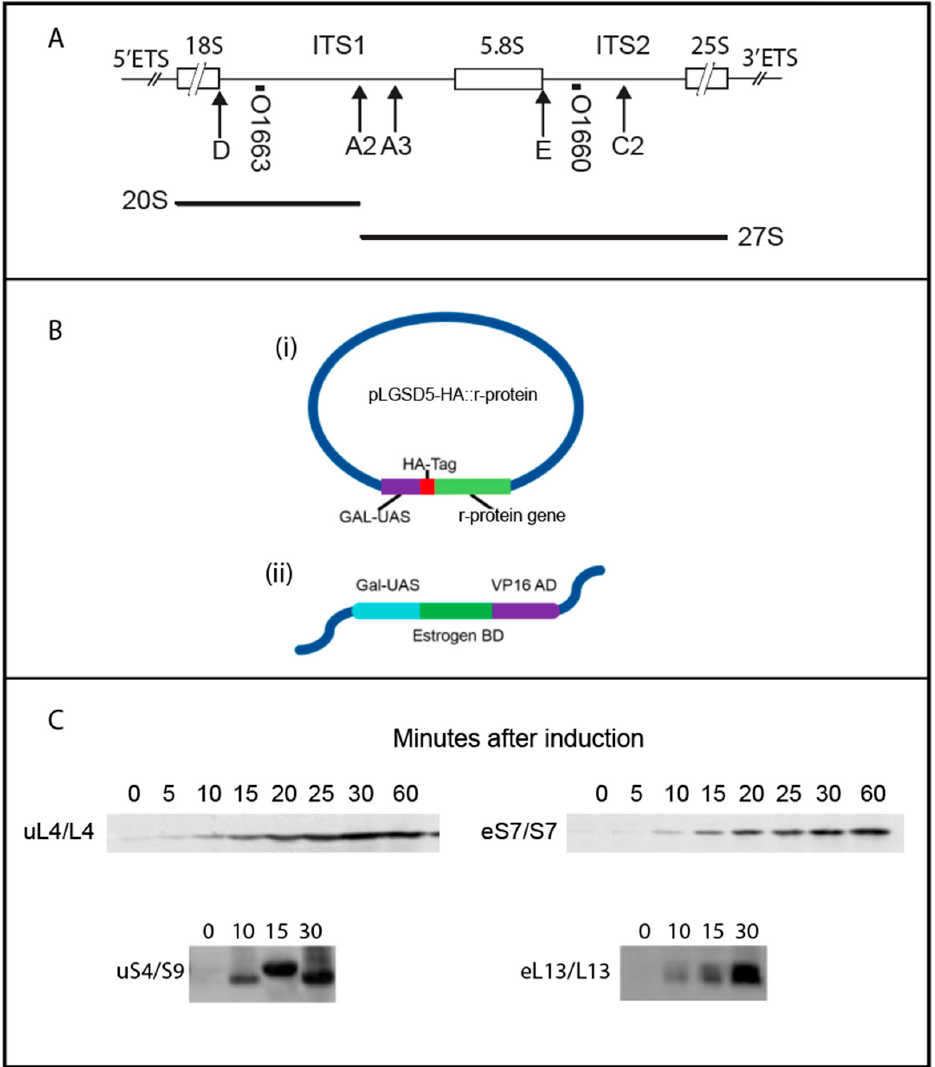
Figure 1. Synthesis of rRNA and hemagglutinin (HA)-tagged ribosomal proteins. ( A ) Map of the rRNA transcription unit with indication of the sequences destined for mature ribosomes (boxes), external (5 ′ ETS and 3 ′ ETS), and internal transcribed spacers (ITS1 and ITS2). Relevant rRNA processing sites are indicated by arrows below the map. Other processing sites are omitted. The short heavy lines immediately below the map show the sequences to which the S. cerevisiae ITS1 and ITS2 oligonucleotide probes (O1663 and O1660) hybridize. ( B ) Genetic constitution of strains used. (i) Plasmid (2 µ) carrying a gene for N-terminally HA-tagged ribosomal protein expressed from a GAL4::CYC1 hybrid promoter. (ii) Gene for a hybrid transcription factor composed of the GAL-DNA binding site, an estrogen response element, and the viral VP16 activating sequence. The gene was integrated in the chromosome. ( C ) Accumulation of HA-tagged uL4, eS7, uS4, and eL13 after addition of β -estradiol was monitored by Western blots probed with anti-HA.